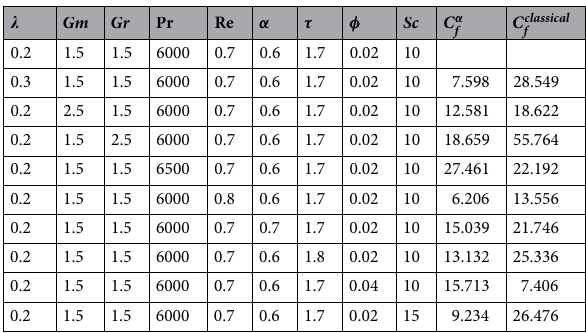
Table 3. Skin friction of grease based MoS 2 Maxwell nanofluid on the right